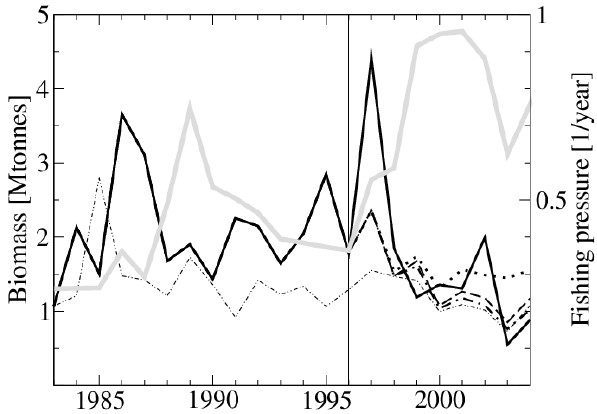
Fig. 4. Hindcast of the 1998–1999 sandeel stock regime shift, with full reanalysis for 1983–1996. The actual computed T matri- ces for 1983–2004 are imposed in all runs. Full thick line: actual stock biomass (left axis) from ICES stock assessment. Dotted line: 1996–2004 hindcast, freezing fishing pressure to 1996 level. Dashed line: 1996–2004 hindcast, imposing actual historic fishing pressure (higher than 1996 level). Dash-dotted line: 1996–2004 hindcast, imposing actual historic fishing pressure along with 20% linear reduction in carrying capacity between 1997 and 2004. Dot-dot- dashed line: full-period 1983–2005 hindcast model run, applying actual historic fishing pressure. Full grey line (right axis): average actual historic fishing pressure, averaged over areas 1–3 for 1-yr-old